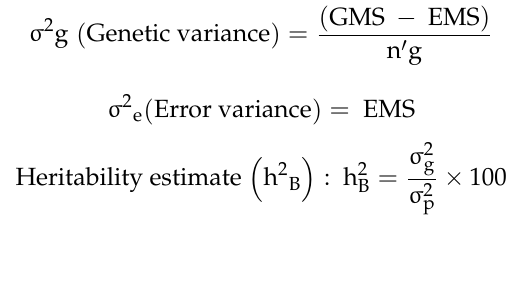
Note: n’, harmonic mean destined for palms in progenies/block or replicate; g, progenies harmonic mean; r, number of blocks or replications; MS, mean squares for the respective source of variation; EMS, expected mean squares based on the sum of squares type